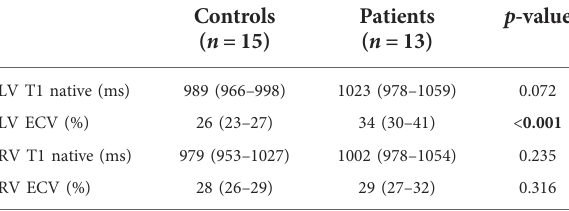
TABLE 2 T1 mapping parameters in controls and patients.